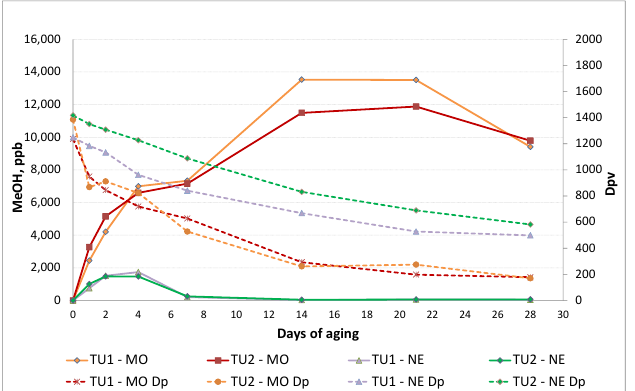
Figure 3. Change of methanol concentration and DP v during aging experiment (TU papers in mineral and natural ester oil at 140